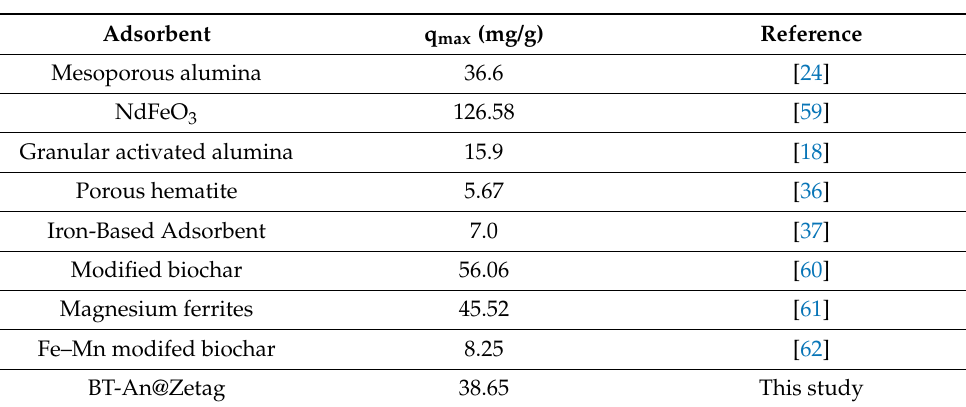
Table 5. Comparison of the maximum adsorption capacity of As(V) for adsorbents from selected studies with the BT-An@Zetag